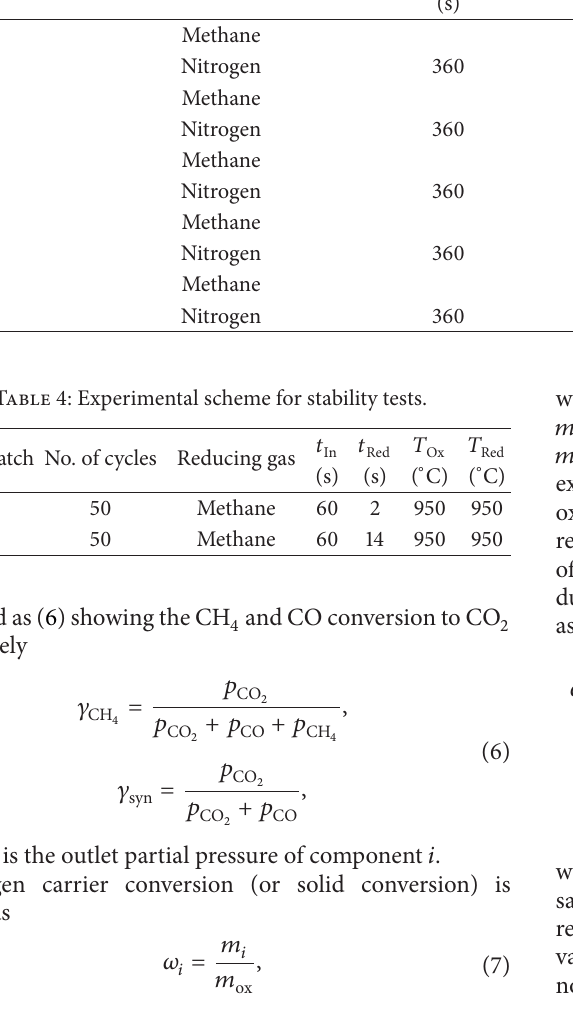
Figure 2: Schematic representation of the laboratory set-up of the batch fluidized bed system. Table 3: Experimental scheme used for investigation of the effect of temperature on the oxygen carrier reactivity. No. of cycles